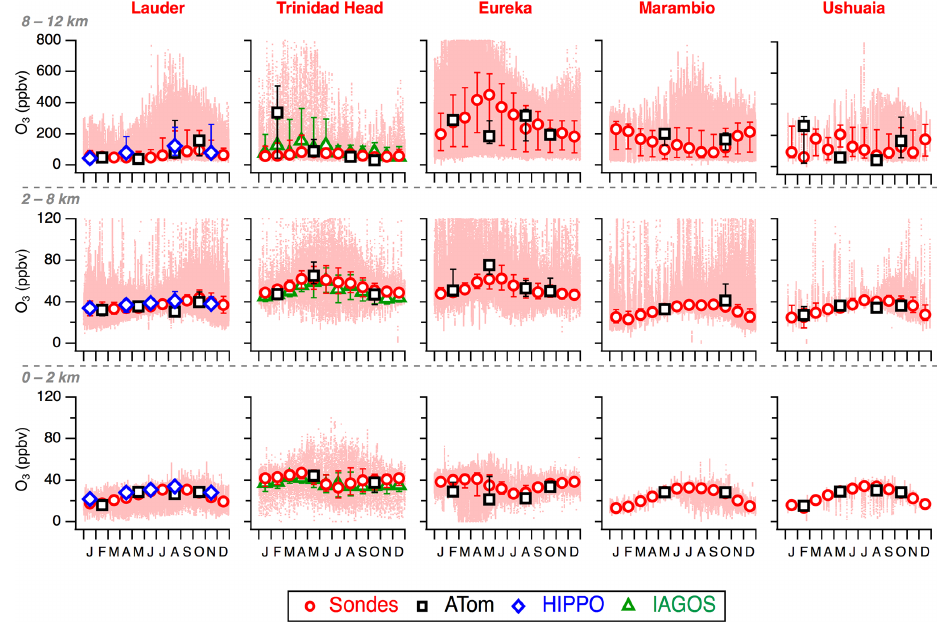
Figure 3. Same as in Fig. 2 but for ozonesonde launching sites located in the middle and high latitudes. O 3 data obtained from the IAGOS program (green triangles) during descents into San Francisco Bay Area airports were also added to the Trinidad Head site for